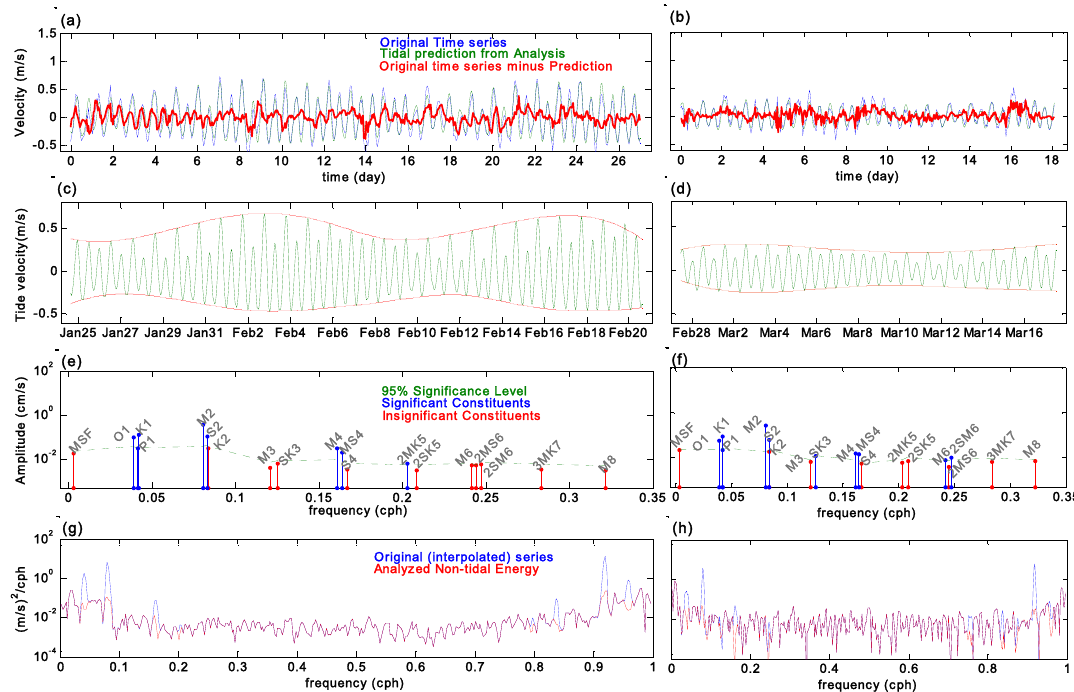
Figure 5. ( a , b ) Demonstration of MATLAB t_tide toolbox analysis for M1 (16.6 mab) and M2 (14.6 mab), respectively. ( c , d ) Tidal currents from t_tide analysis. ( e , f ) Analyzed lines with 95% significance levels for M1 and M2, respectively. ( g , h ) Spectral estimates before and after the removal of tidal energy for M1 and M2, respectively.